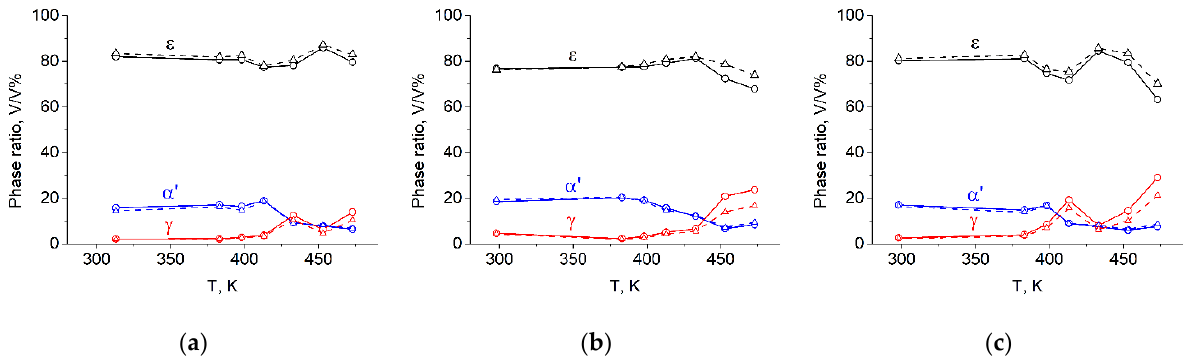
Figure 6. Phase ratios calculated from the measured, absorption- corrected γ{111}, α’{110} and ε{002} pole figures of the steel specimens tensile tested at different temperatures. The results obtained with the method proposed by Wassermann and Grewen are marked with dashed lines; those obtained with the revised method are marked with solid lines. ( a ) Steel 0.07, ( b ) Steel 2.26, ( c ) Steel 6.12.